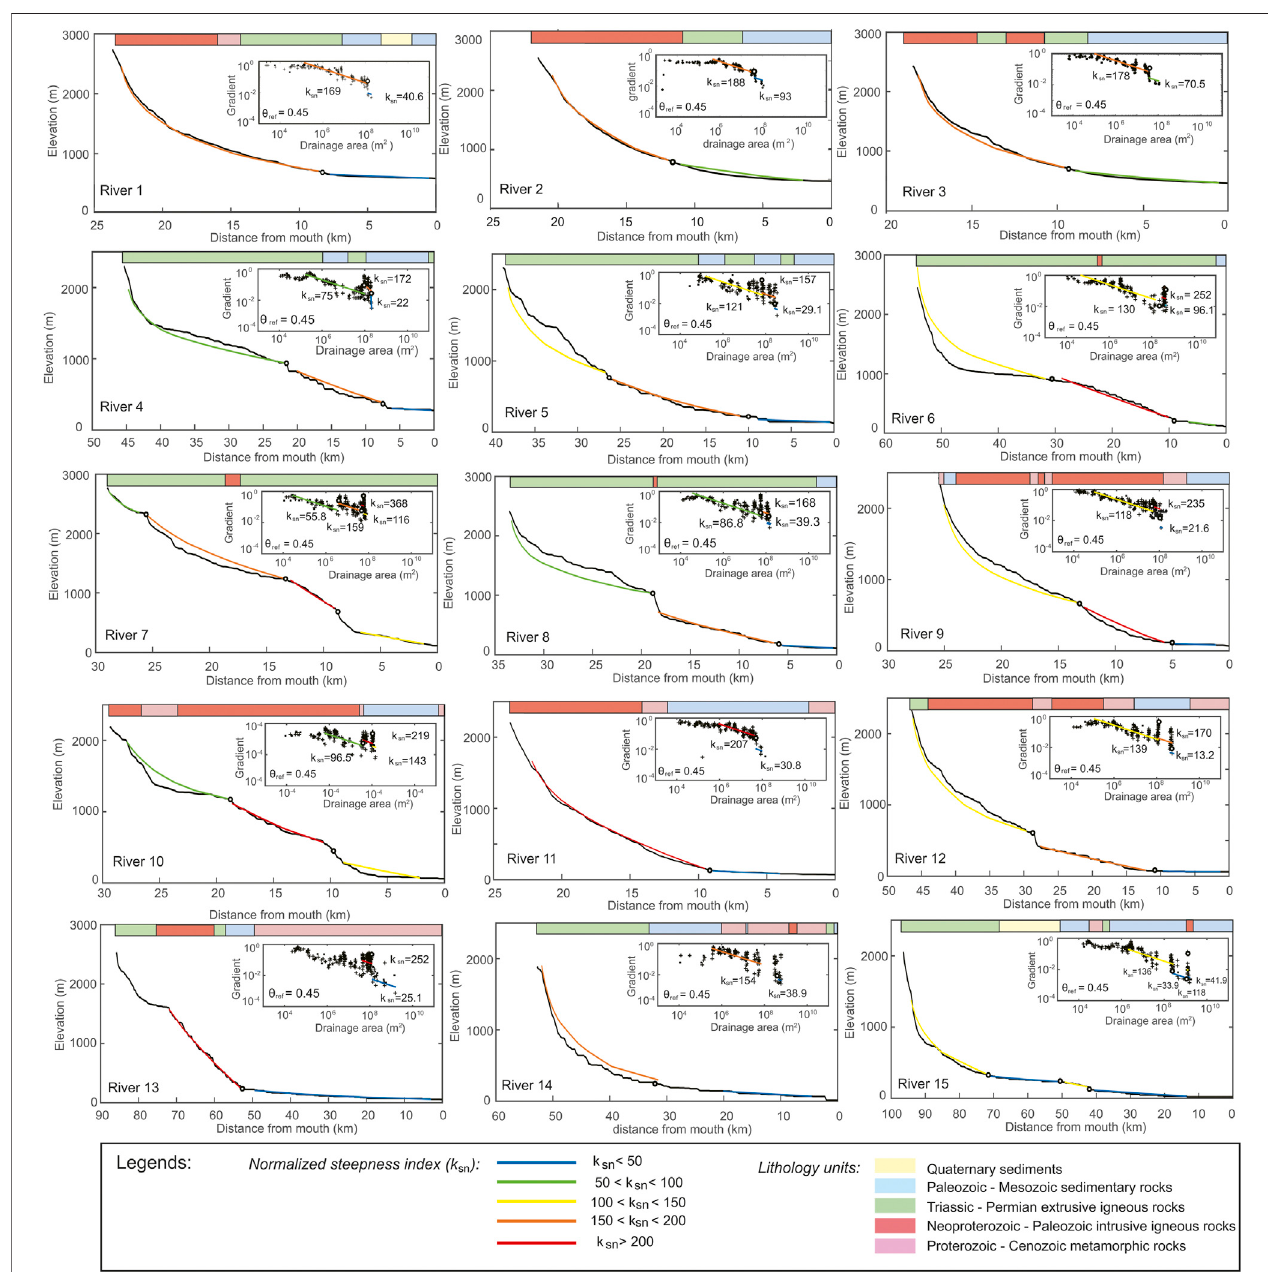
FIGURE 11 | Longitudinal river pro fi les and the values of the normalized steepness index (k sn ) along the analyzed rivers. The lithology units where the river fl ows througharepresentedabovethelongitudinalriverpro fi leswiththecolorcorrespondingtothesamecolorasshowningeologicalmap( Figure2 ).Upperrightrectangular represents log-log plots of gradient and drainage area data. The locations of the analyzed rivers are shown in Figure 3 . The back circles on both the longitudinal river pro fi lesandlog-logplotsofgradientanddrainagearearepresentknickpoints.Thevaluesofthenormalizedsteepnessindexareindicatedbydifferentcoloredlines.